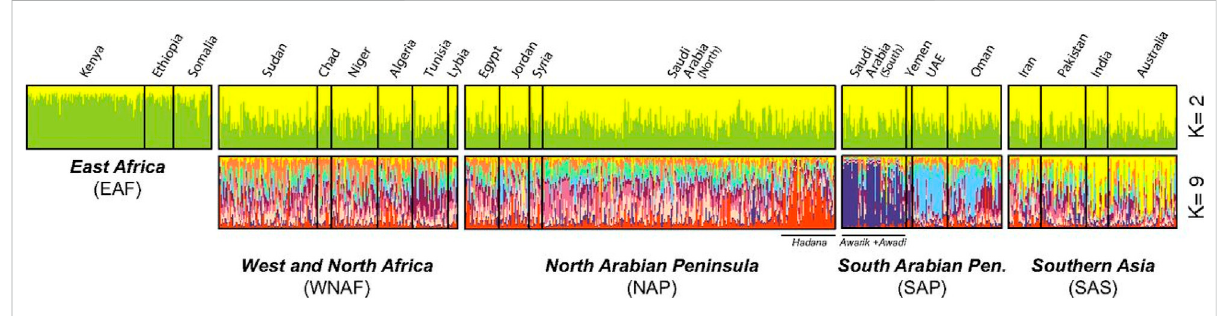
FIGURE 1 A structure analysis plot showing the domestication of African camels. Source: Almathen et al.